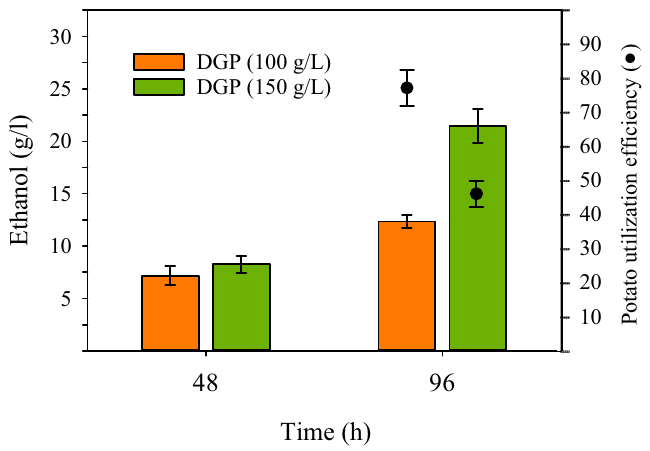
Figure 7. CBP ethanol production by strain NS:Z (Δ ldh , adh S : pdc Z ). Cultures were conducted in 2YT medium supplemented with 100 and 150 g/L dried ground potatoes (DGP) at 37 °C, 180 rpm under limited aeration conditions. The dots (black filled circle) represent the efficiency of potato utilization